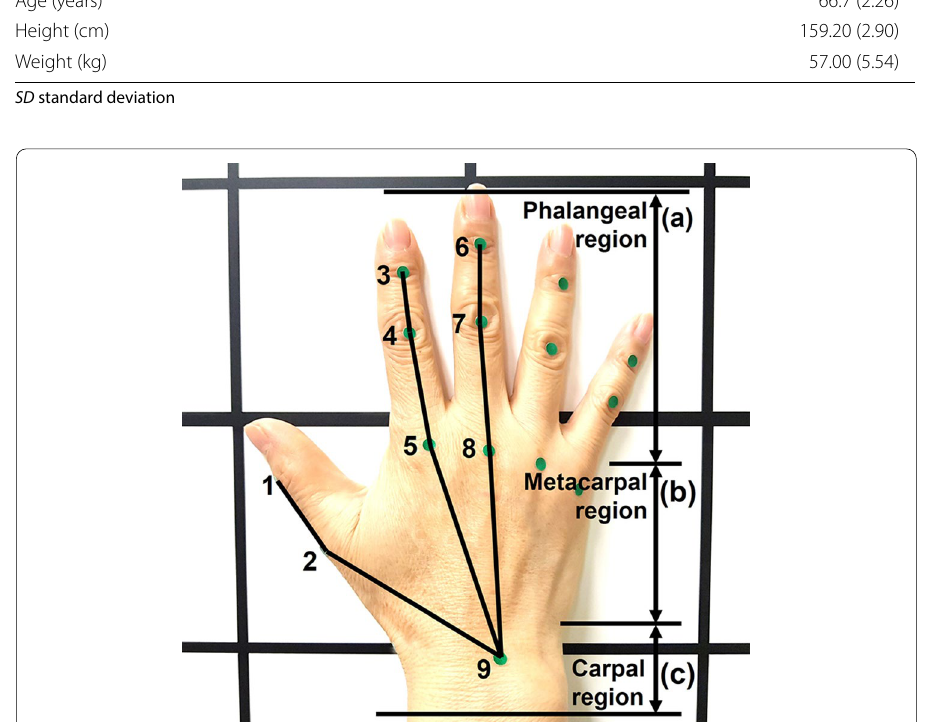
Fig. 1 Measurement positions and points on the participant’s hand for 3D scanning. Phalangeal region, metacarpal region, and carpal